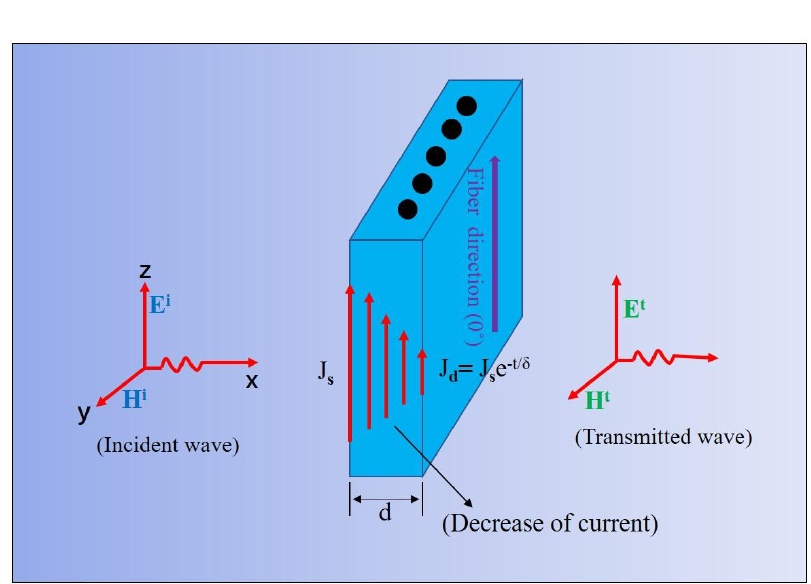
Figure 5. Schematic of EMI shielding mechanism of unidirectional CFRP.